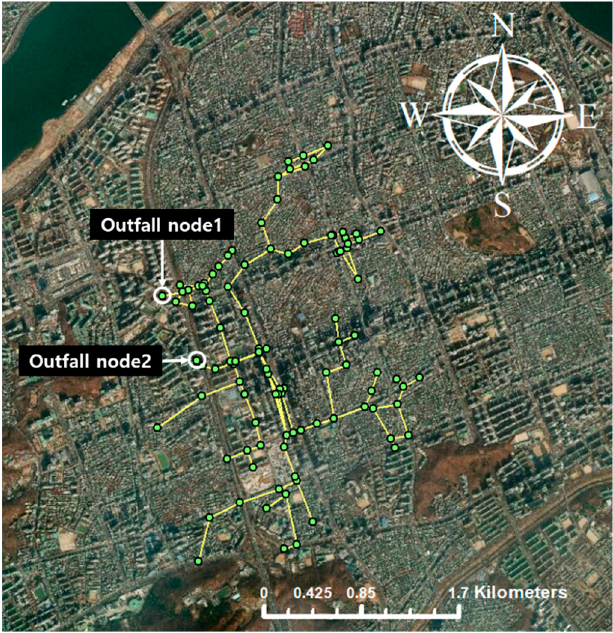
Figure 3. Drainage System for one-dimensional simulation.